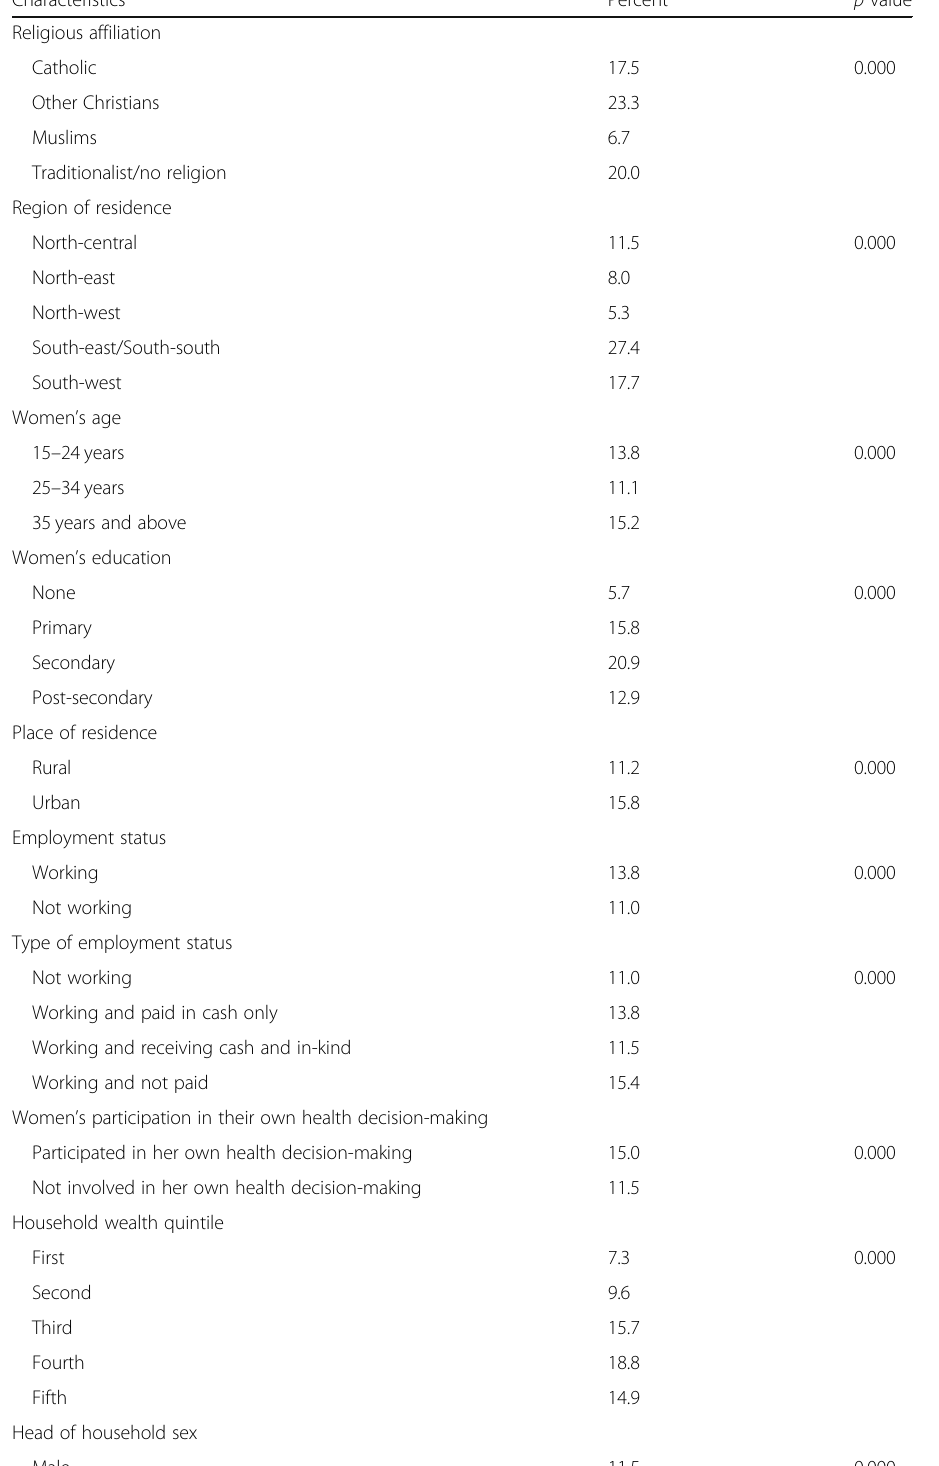
Table 2 Percent of women who experienced unintended in the past 2 years in Nigeria (NDHS 2018), N = 13,109